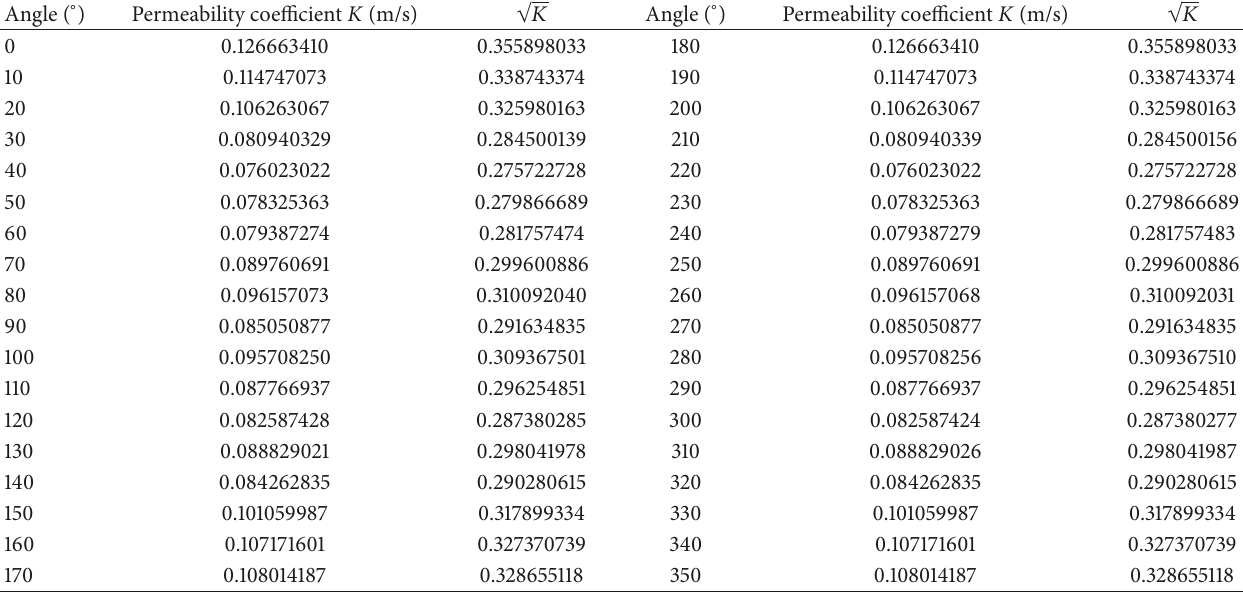
Table 2: Geometry parameters of the simulation fractures.